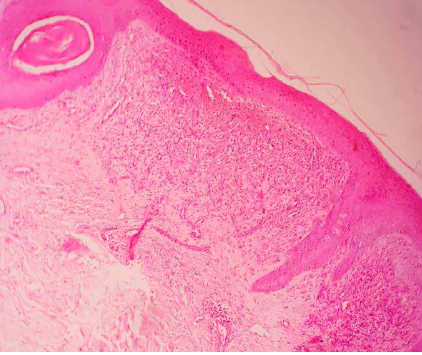
Figure 2: Skin biopsy results.